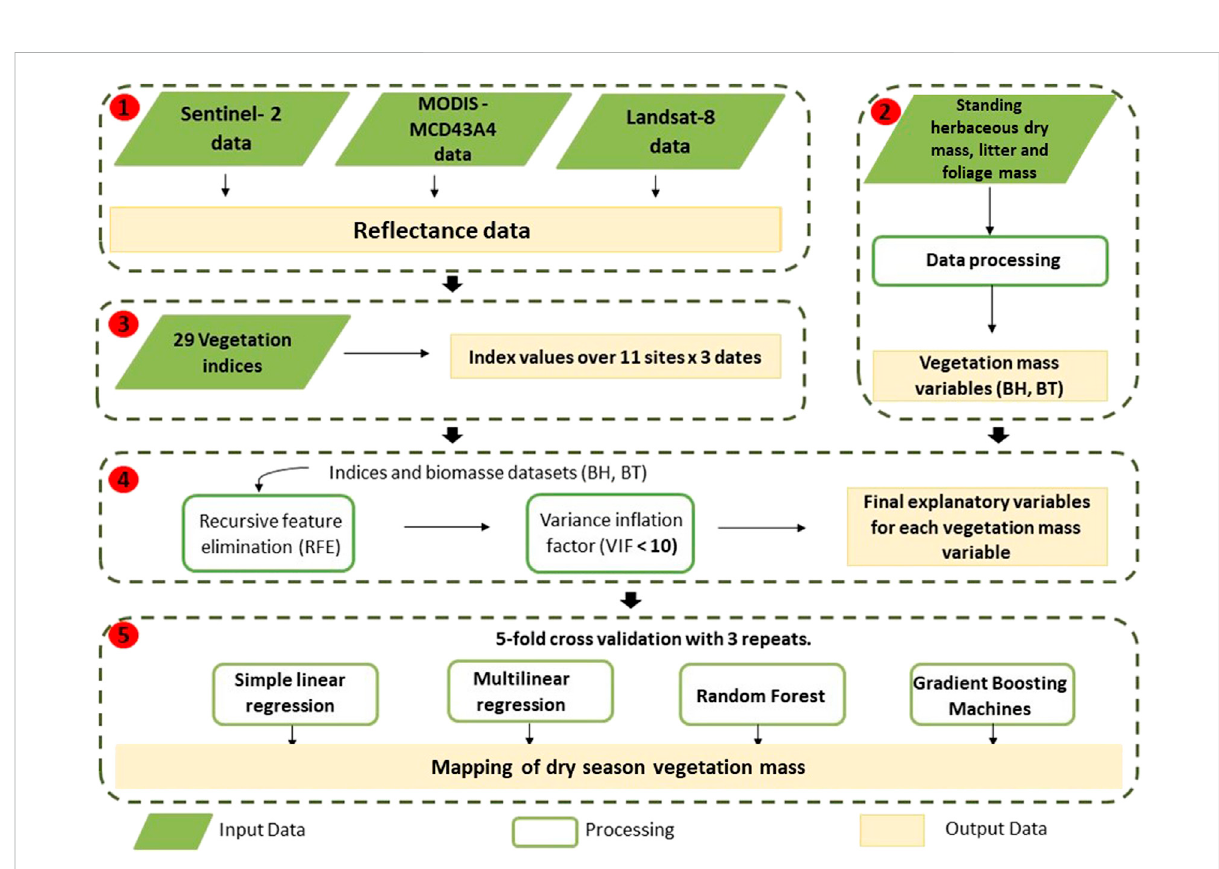
FIGURE 2 Flowchart of the main steps of the study with 1) satellite data pre-processing, 2) preparation of fi eld observed BH and BT, 3) satellite index calculation, 4) selection of explanatory variables, and 5) parameterization and validation of